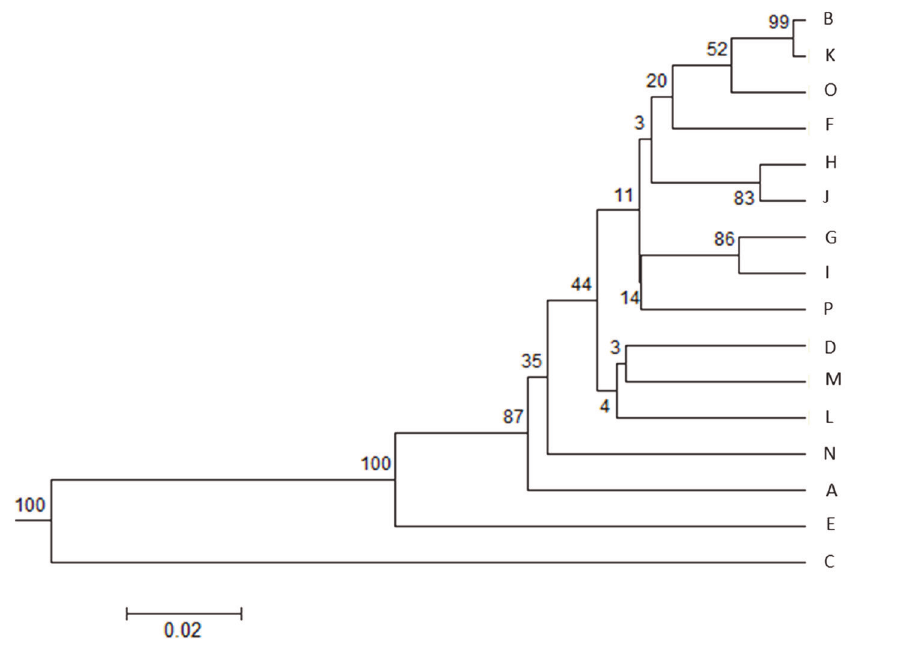
Figure 5. UPGMA tree of Nei’s genetic distance of Limousin cattle from 16 farms. Bootstrap values are indicated on the